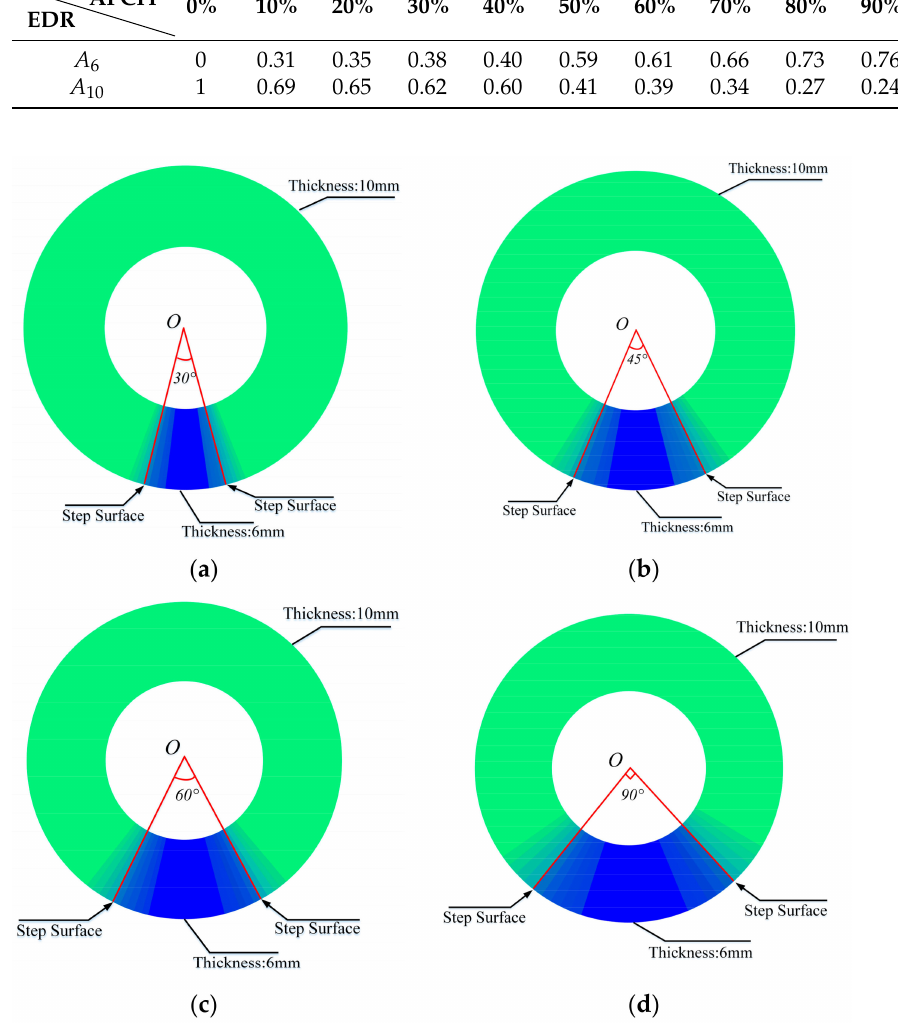
Figure 17. EDR amplitude quantification diagram of specimen 1. ( a ) Sector angle 30 ◦ . ( b ) Sector angle 45 ◦ . ( c ) Sector angle 60 ◦ . ( d ) Sector angle 90 ◦